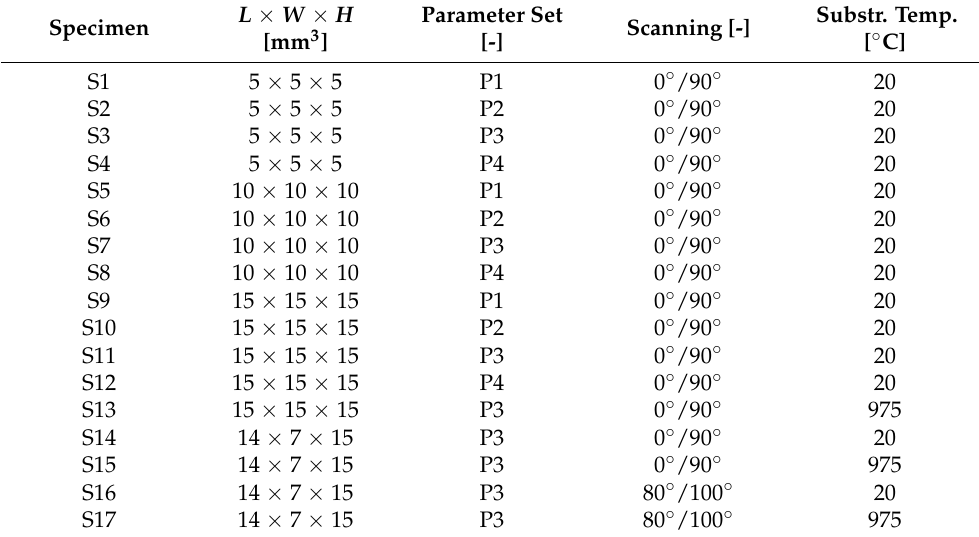
Table 2. Experimental conditions for the specimen fabrication.